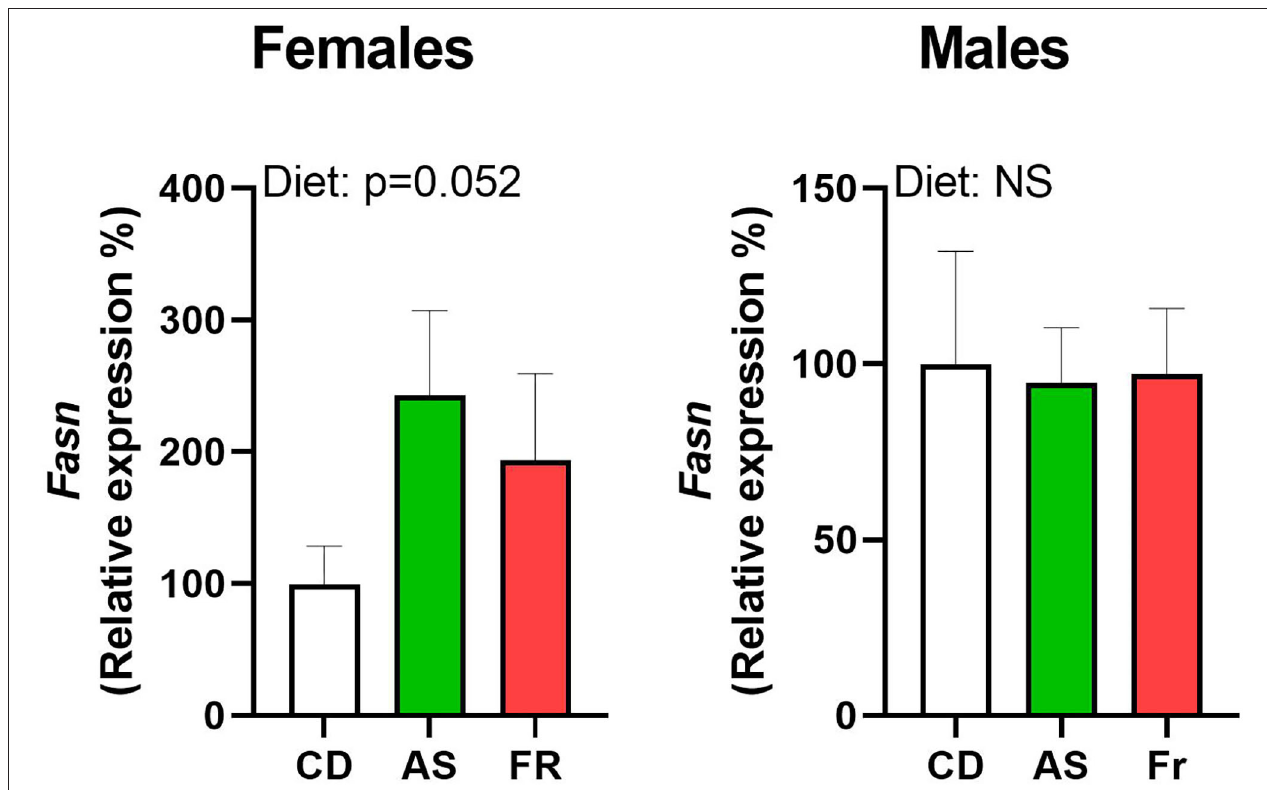
FIGURE 4 | The impact of maternal Ace-K (AS) and fructose (Fr) intake compared to Controls (CD) on Fasn gonadal tissue gene expression in female and male C57BL/6 offspring. Data were analyzed using one-way ANOVA. Data are expressed as mean ± SEM. n = 8 per sex per group.